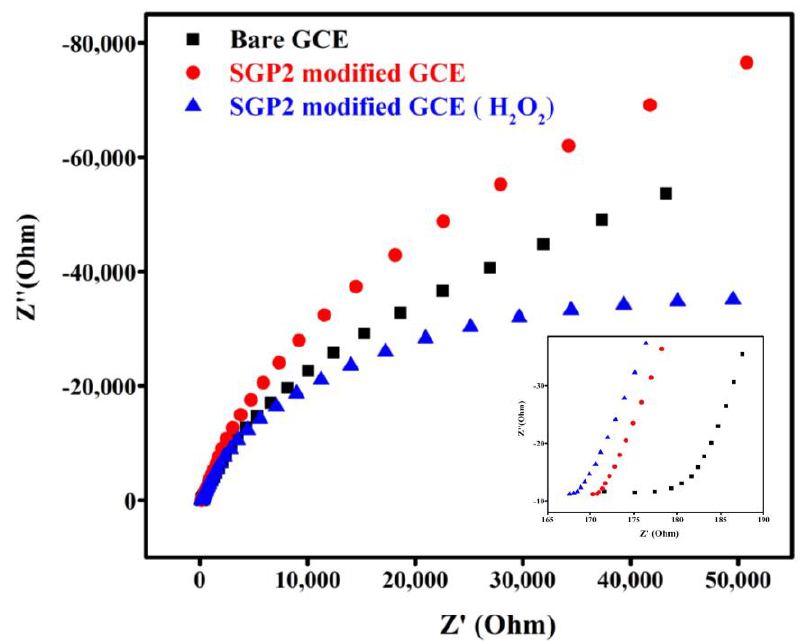
Figure 7. EIS analysis of bare GCE, SGP2 modified GCE, and SGP modified GCE in the presence of H 2 O 2 .